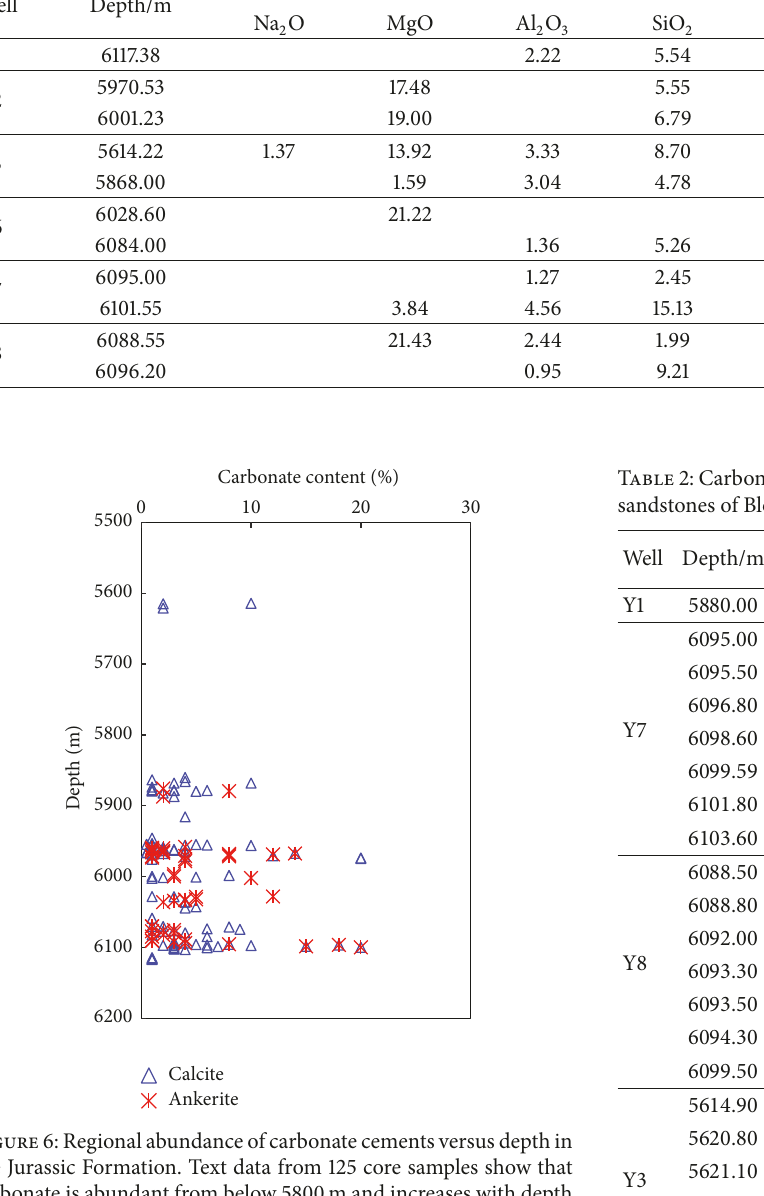
Table 1: Composition from EDX analysis of carbonate cements in sandstone of Block 3. Well